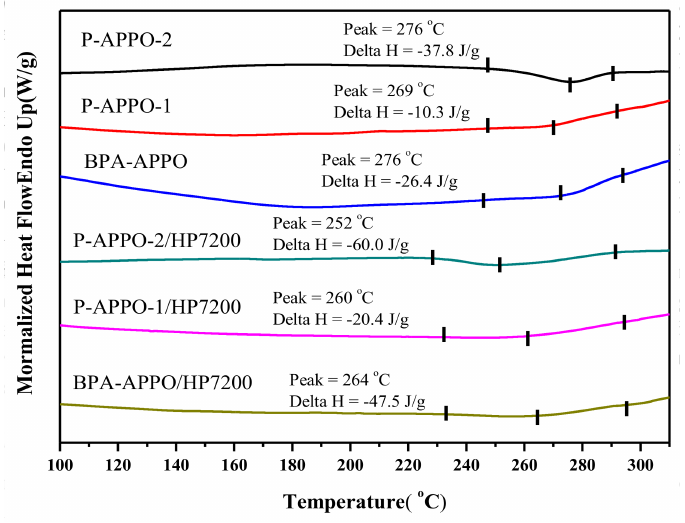
Figure 6. DSC thermograms of three PPO-containing benzoxazines and the benzoxazine/HP7200 blends.